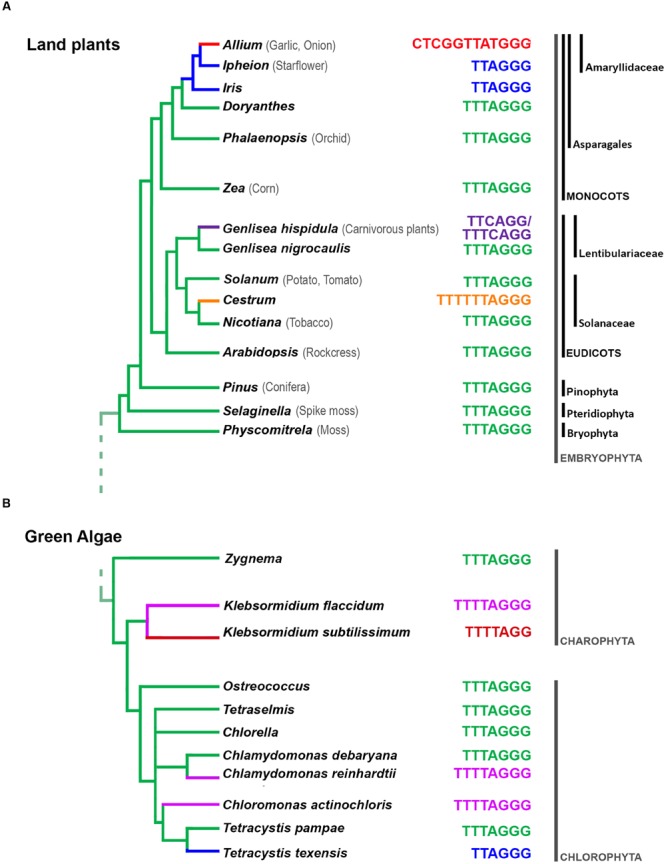
Summary of current knowledge on telomere DNA diversity in land plants (A) and green algae (B). The prevalent plant telomeric sequence motif TTTAGGG was first described in A. thaliana (Richards and Ausubel, 1988). Divergent telomeric sequences have been observed in Asparagales (Sykorova et al., 2003), in Cestrum spp. (Peska et al., 2015), in Genlisea (Tran et al., 2015), or in Allium (Fajkus et al., 2016). While Arabidopsis-type telomeric sequence is dominant in “green lineages” of algae Chlorophyta and Streptophyta, this ancestral motif was replaced several times with a novel motifs (reviewed in Fulnečková et al., 2015). (The relationships between families and genera are adapted from the schematic phylogenetic tree presented in Fulnečková et al., 2015 and Fajkus et al., 2016.)